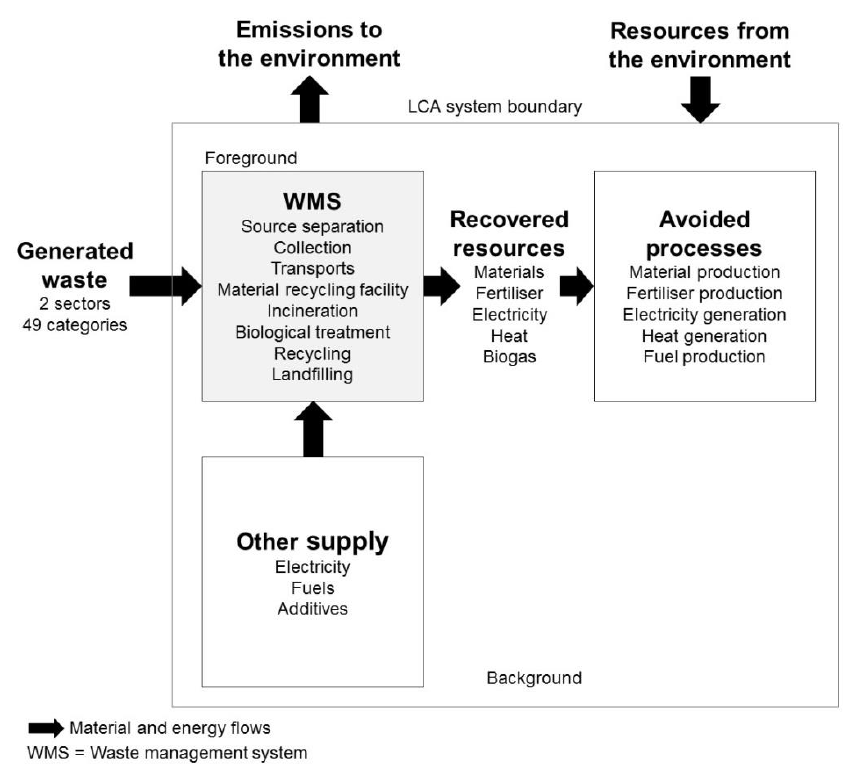
Figure 1. General outline of SWEA model [19].